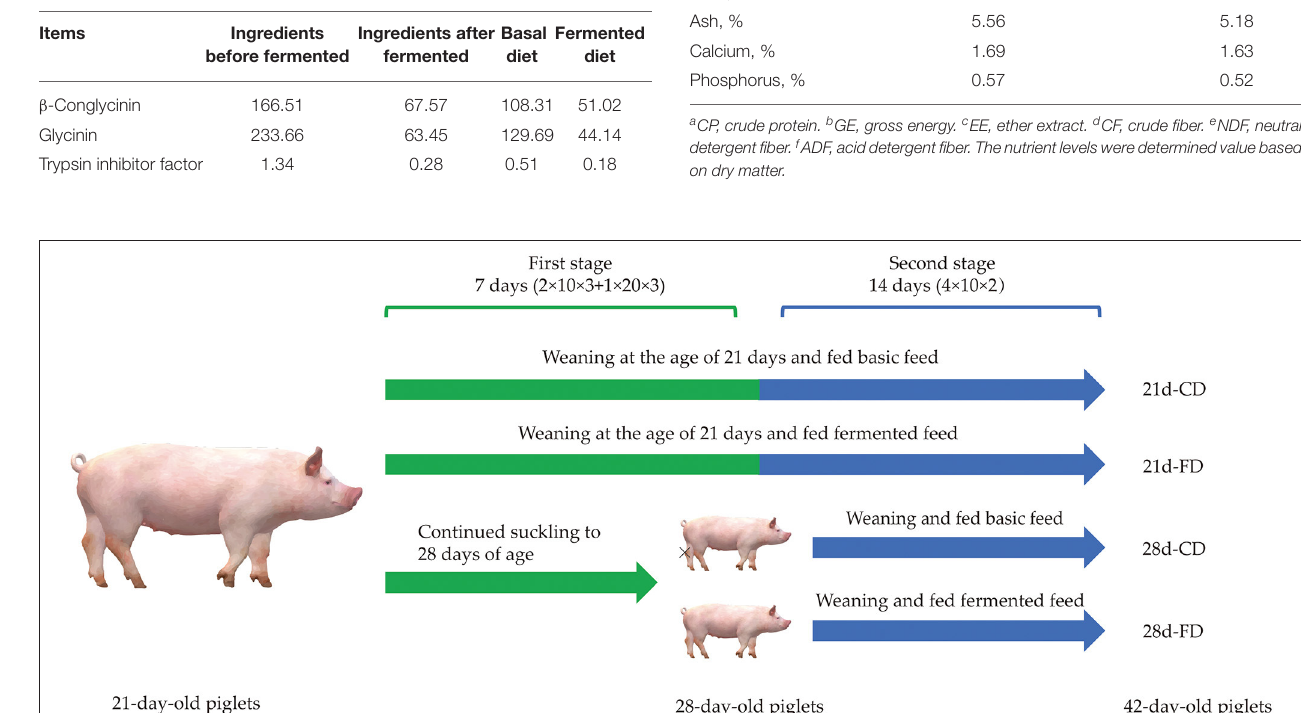
TABLE 2 | Contents of anti-nutritional factors (mg/g). Items Ingredients β -Conglycinin